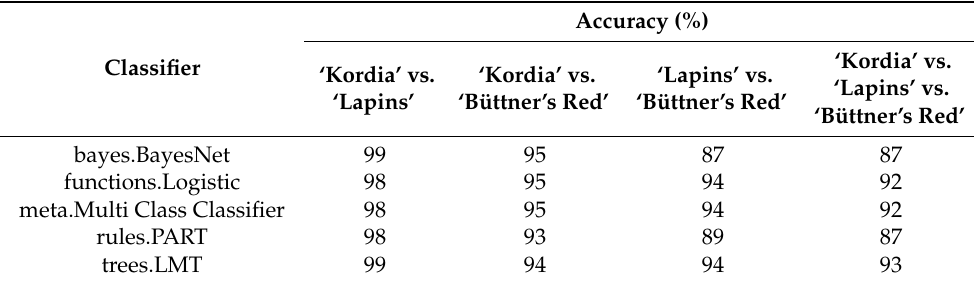
Table 5. The accuracy of discrimination of the endocarp (pit) of different sweet cherry cultivars based on selected geometric features.